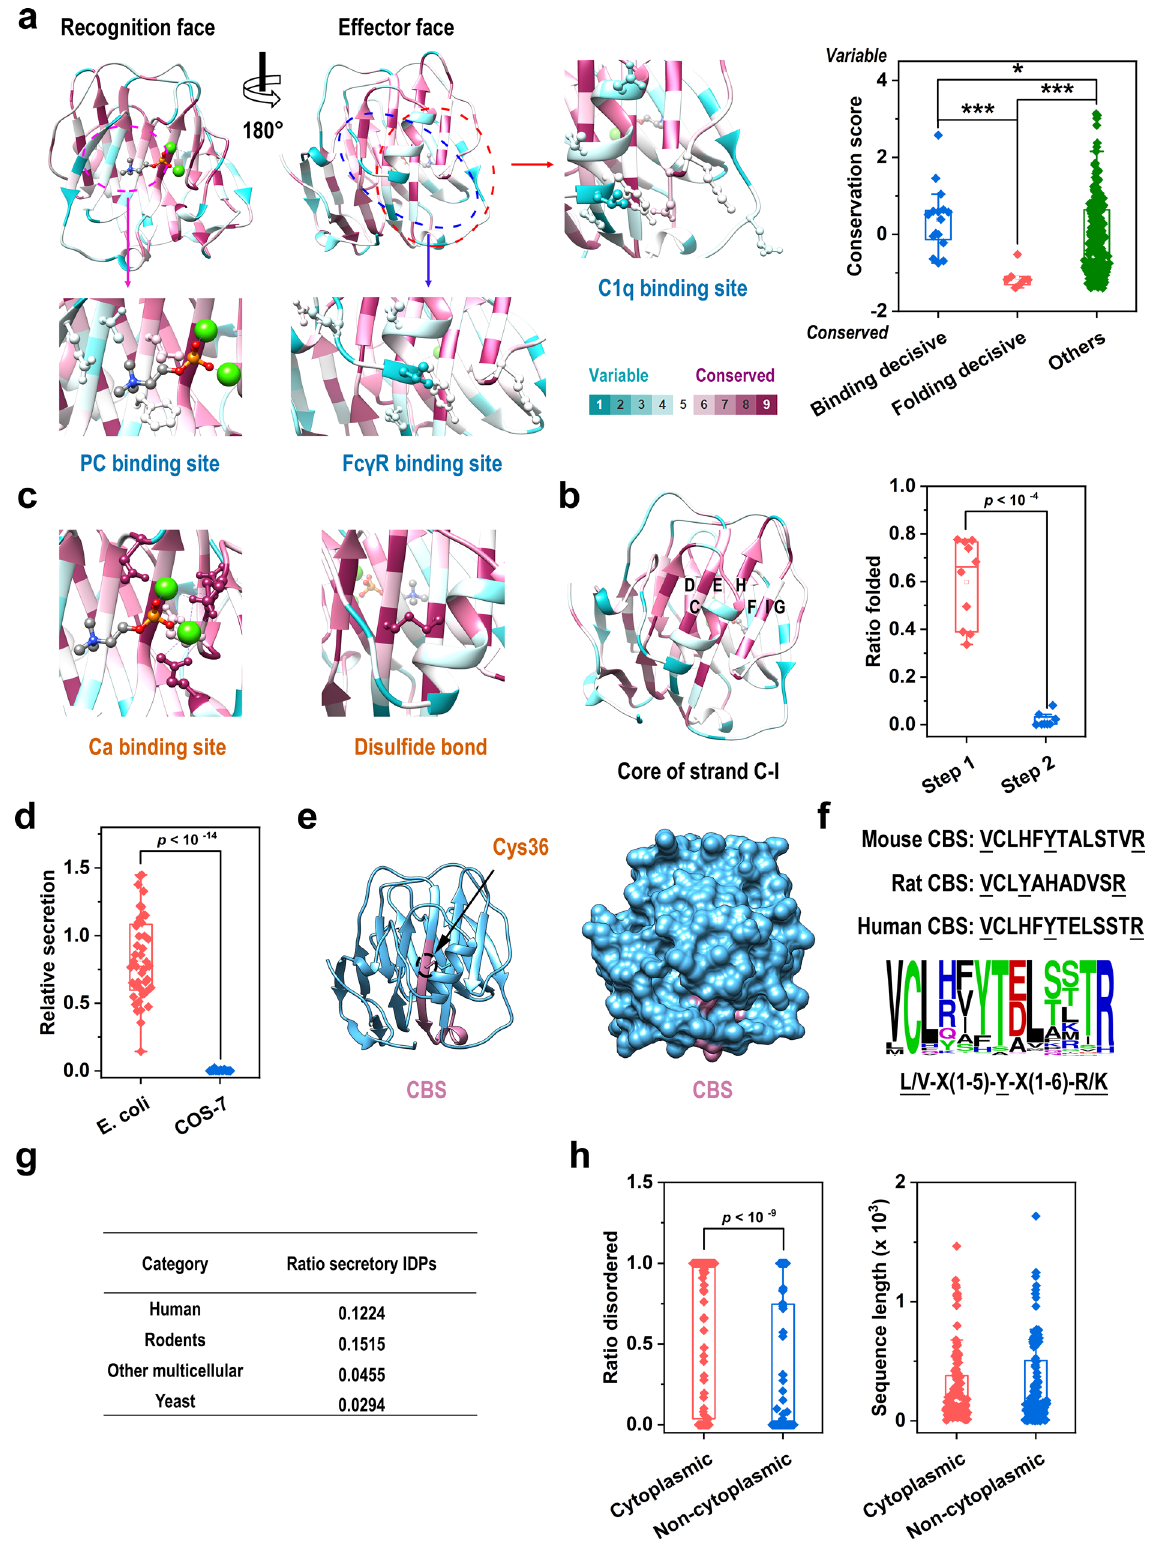
than the coding sequence (Supplementary Figure 2). Second, the drastic difference in circulating levels and acute phase responses of mouse, rat, and human CRP cannot be explained by coding muta- tions. Third, noncoding mutations are usually more tolerable and milder, permitting not only their progressive accumulation during evolution to generate stronger impact but also gradual